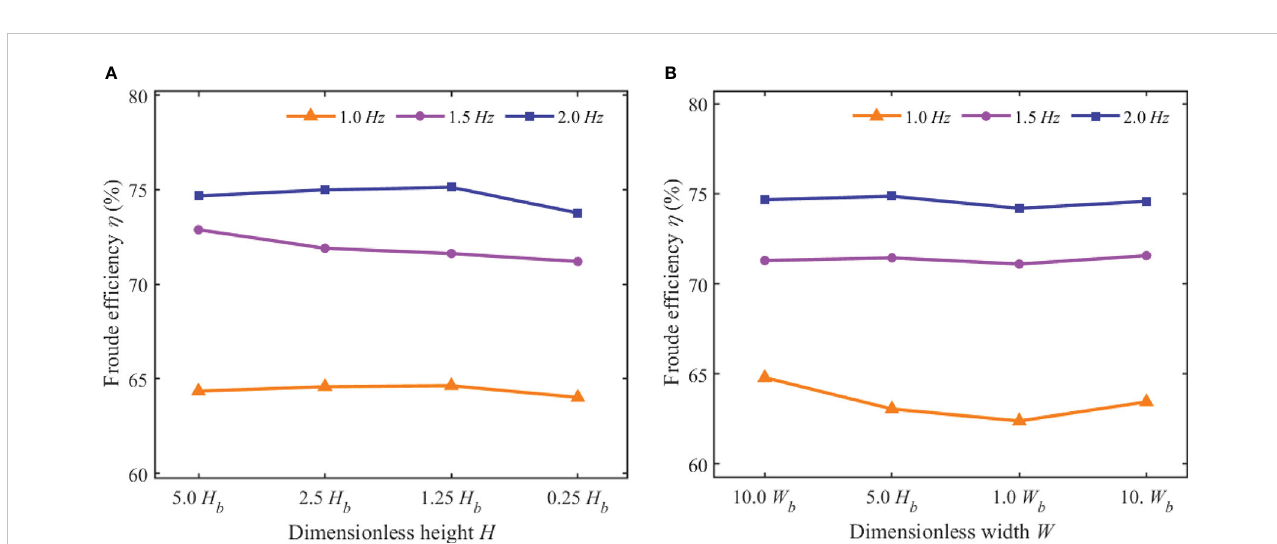
FIGURE 10 Froude ef fi ciency of the swimmer at different values of f , H , and W . (A) Froude ef fi ciency at different values of f and H (B) Froude ef fi ciency at different values of f and W .